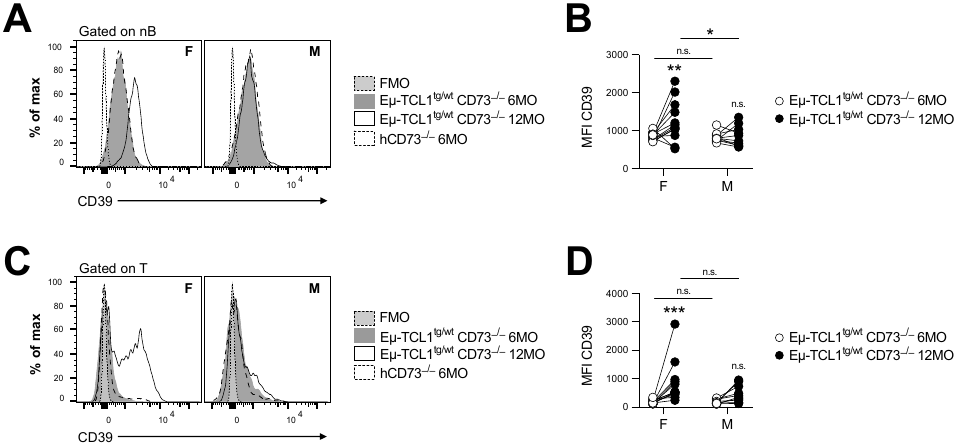
Figure 3. CD73-deficient E µ -TCL1 tg/wt males fail to upregulate CD39 in peripheral blood. Peripheral blood (PB) cells of male (M) and female (F) CD73 − / − Eµ-TCL1 tg/wt mice were analyzed at 6 ( n = 22 F and n = 13 M) and 12 ( n = 12 F and n = 10 M) months old (MO). CD39 expression levels shown by mean fluorescence intensity (MFI) on PB ( A , B ), normal B cells (nB; CD5 neg B220 hi ) and ( C , D ) pan-T cells (T; CD5 hi B220 neg ). Six-month-old hCD73 − / − littermates were used as control. Means +/ − SEM are shown (* p < 0.05; ** p < 0.01; *** p < 0.001 by 2-way ANOVA). FMO, fluorescence minus one; MO, months; hCD73 − / − , healthy CD73 − / − ; nB, normal B cells; n.s., non-significant; MFI, mean fluorescence intensity.